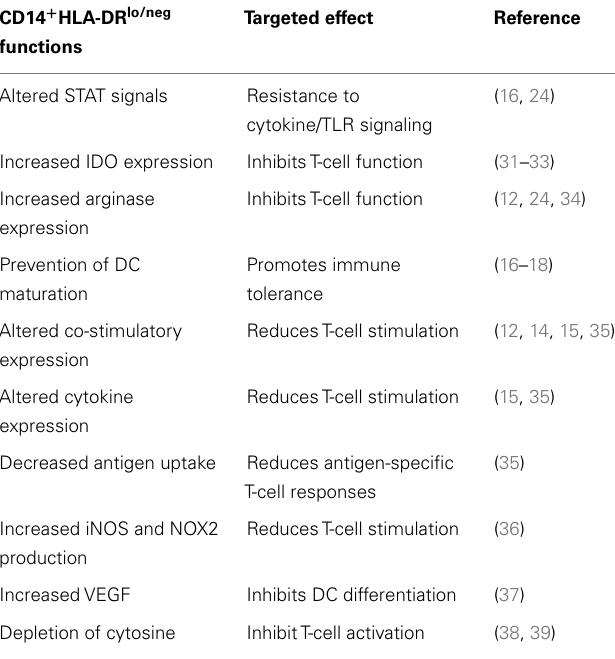
Table 1 | Methods of CD14 + HLA-DR lo/neg immune